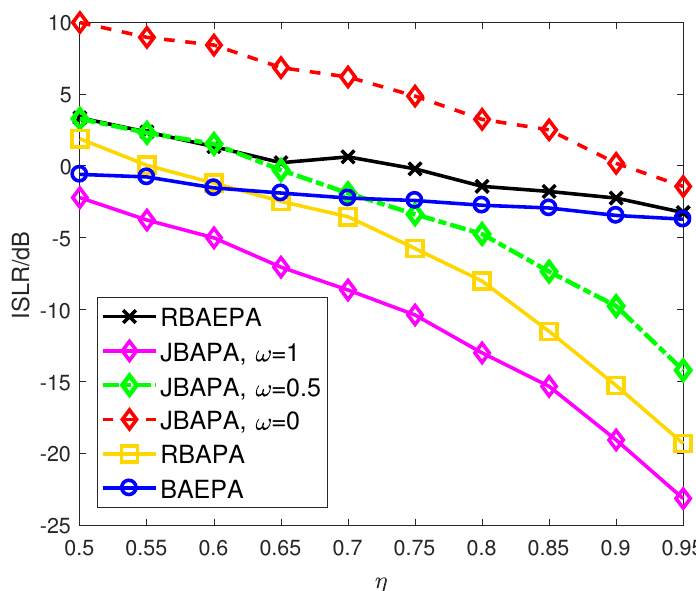
Figure 5. Comparison of the ISLR of different schemes.